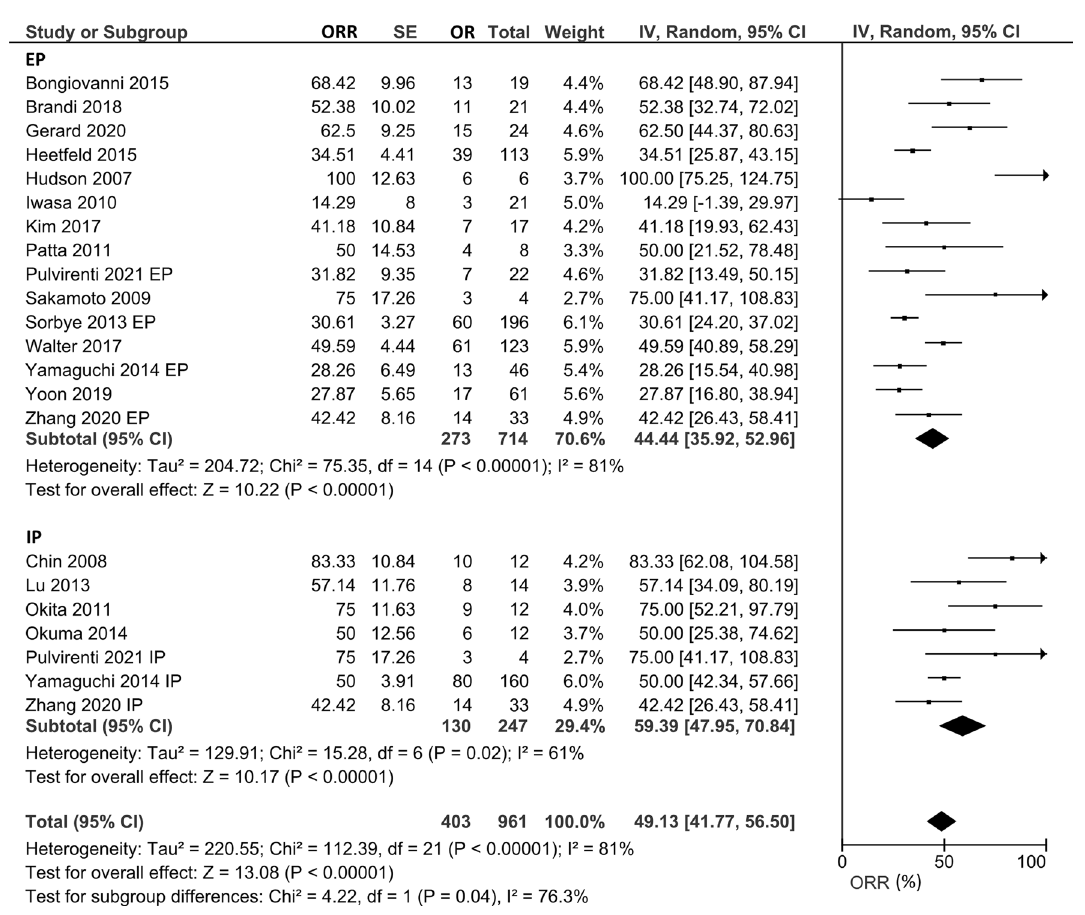
Fig. 2 Pooled ORR in patients treated with platinum-doublet chemotherapy. 15 studies that evaluated patients treated with EP and seven studies that evaluated patients with IP were included in this analysis. ORR overall response rate, EP platinum plus etoposide, IP platinum plus irinotecan